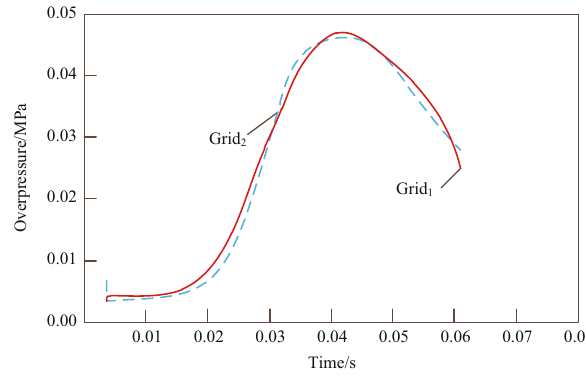
Figure 2: Grid validation diagram.